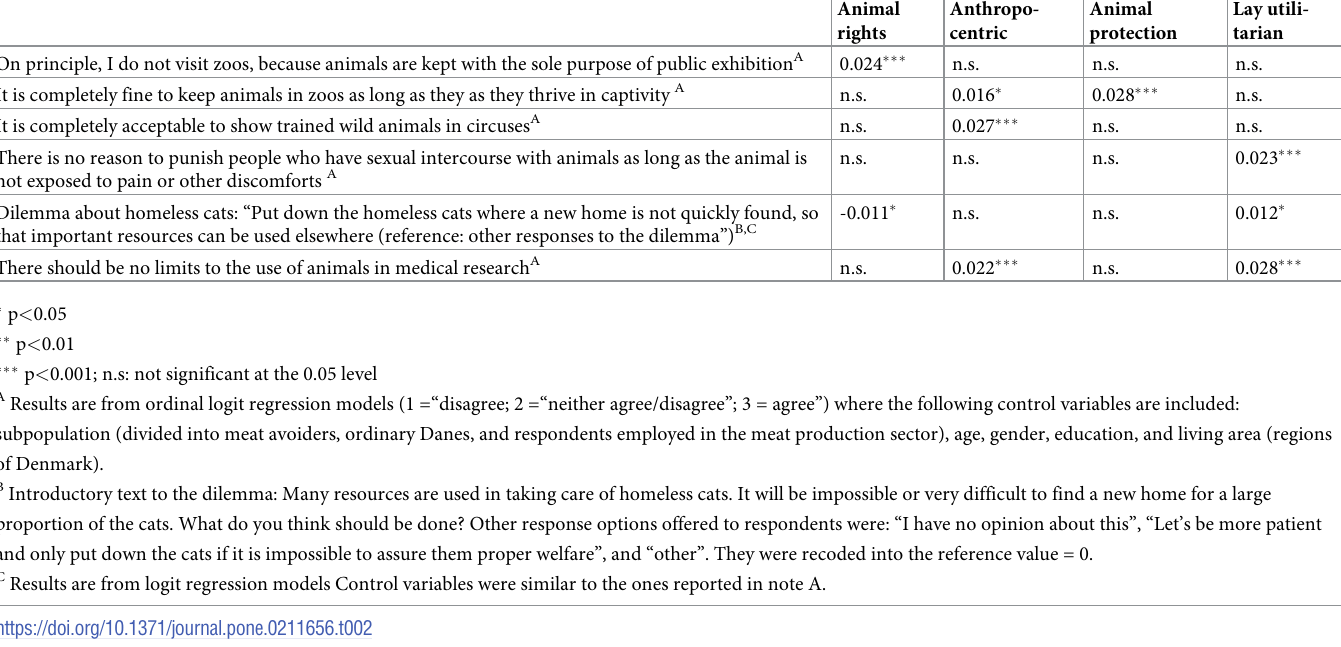
(56df); p < 0.001) and parallel model (CFI .961/TLI .960/ RMSEA 0.059(90%CI 0.048–0.070)/